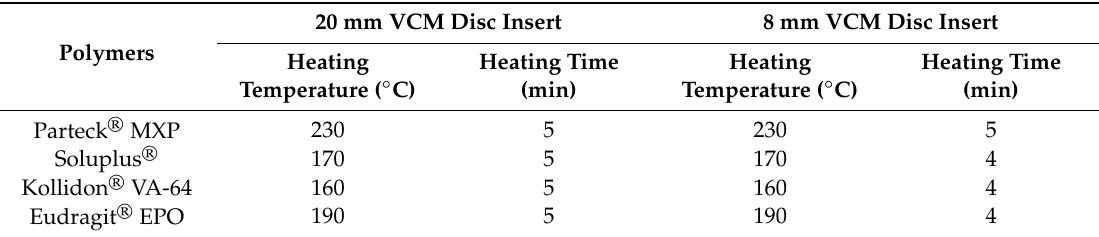
Table 3. Processing parameter of VCM samples.